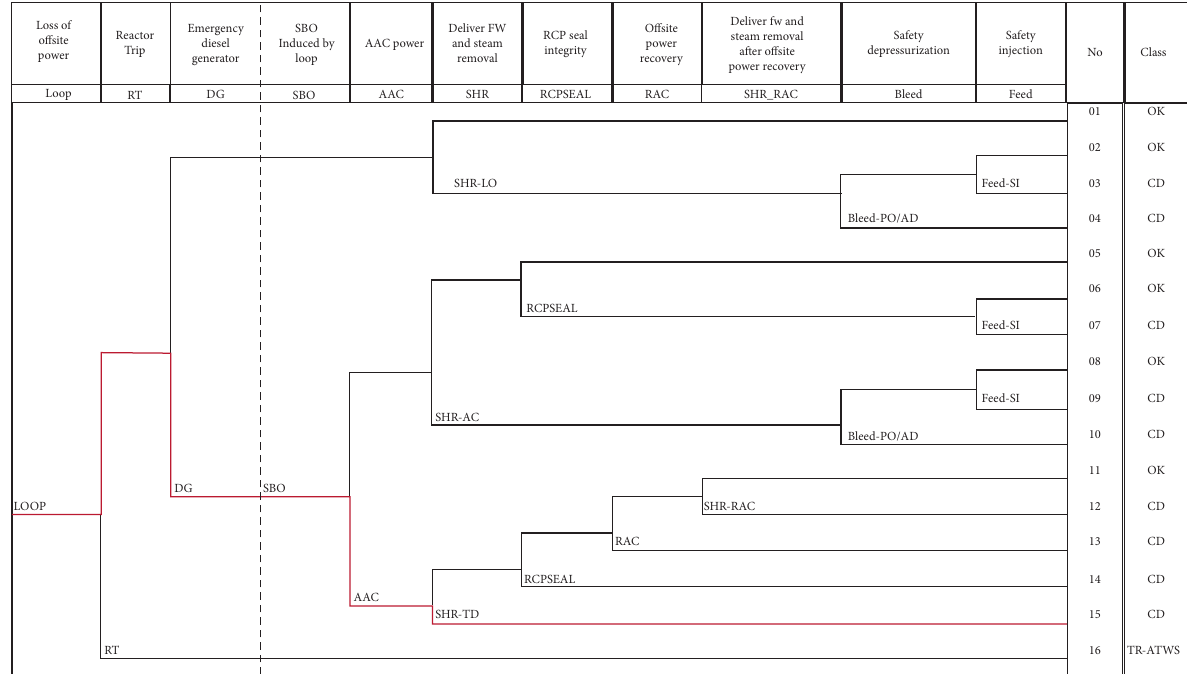
Figure 6: Level 1 event tree for the representative station blackout